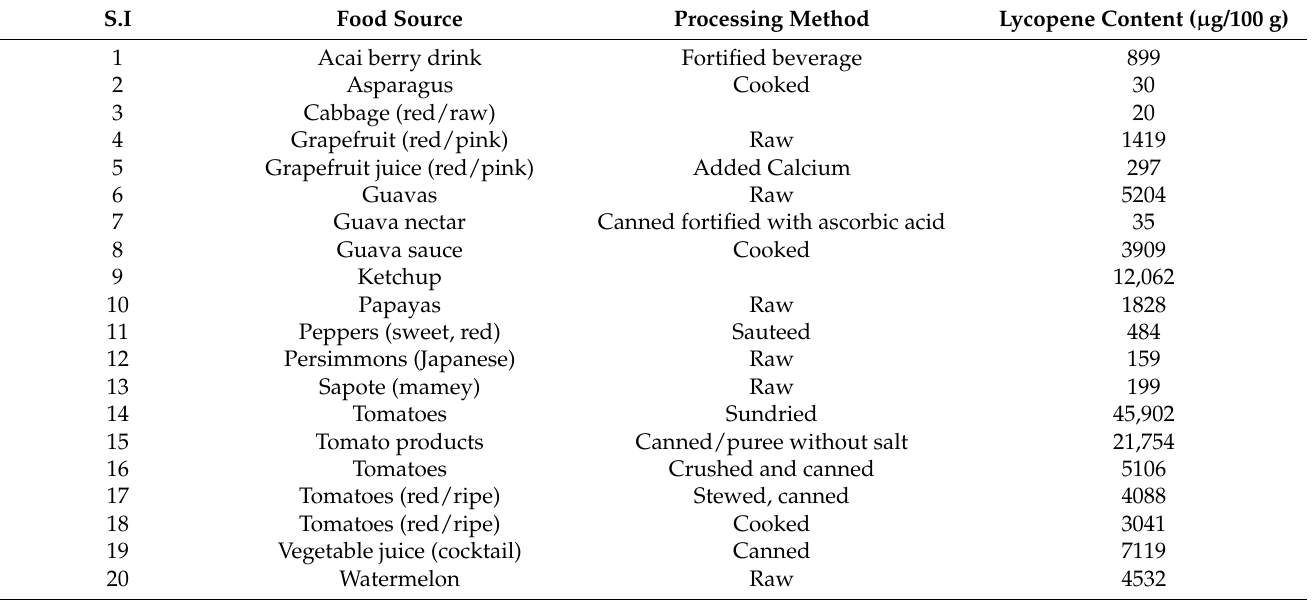
Table 1. Lycopene sources with processing method and lycopene